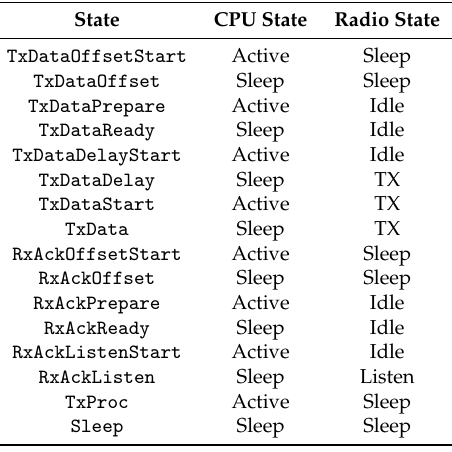
Table 7. States in a TxDataRxNoAck